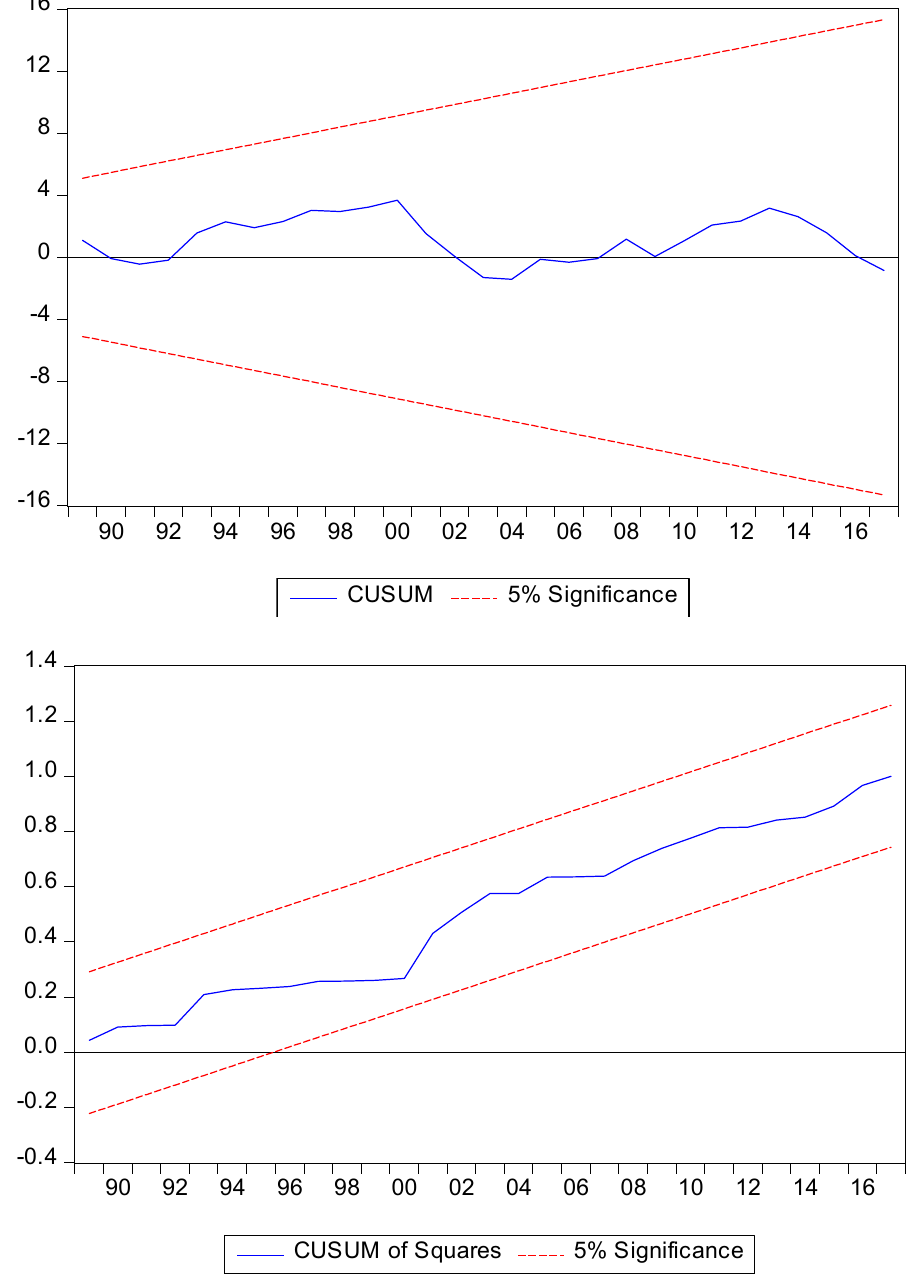
Figure A2. CUSUM of Squares at 5%.